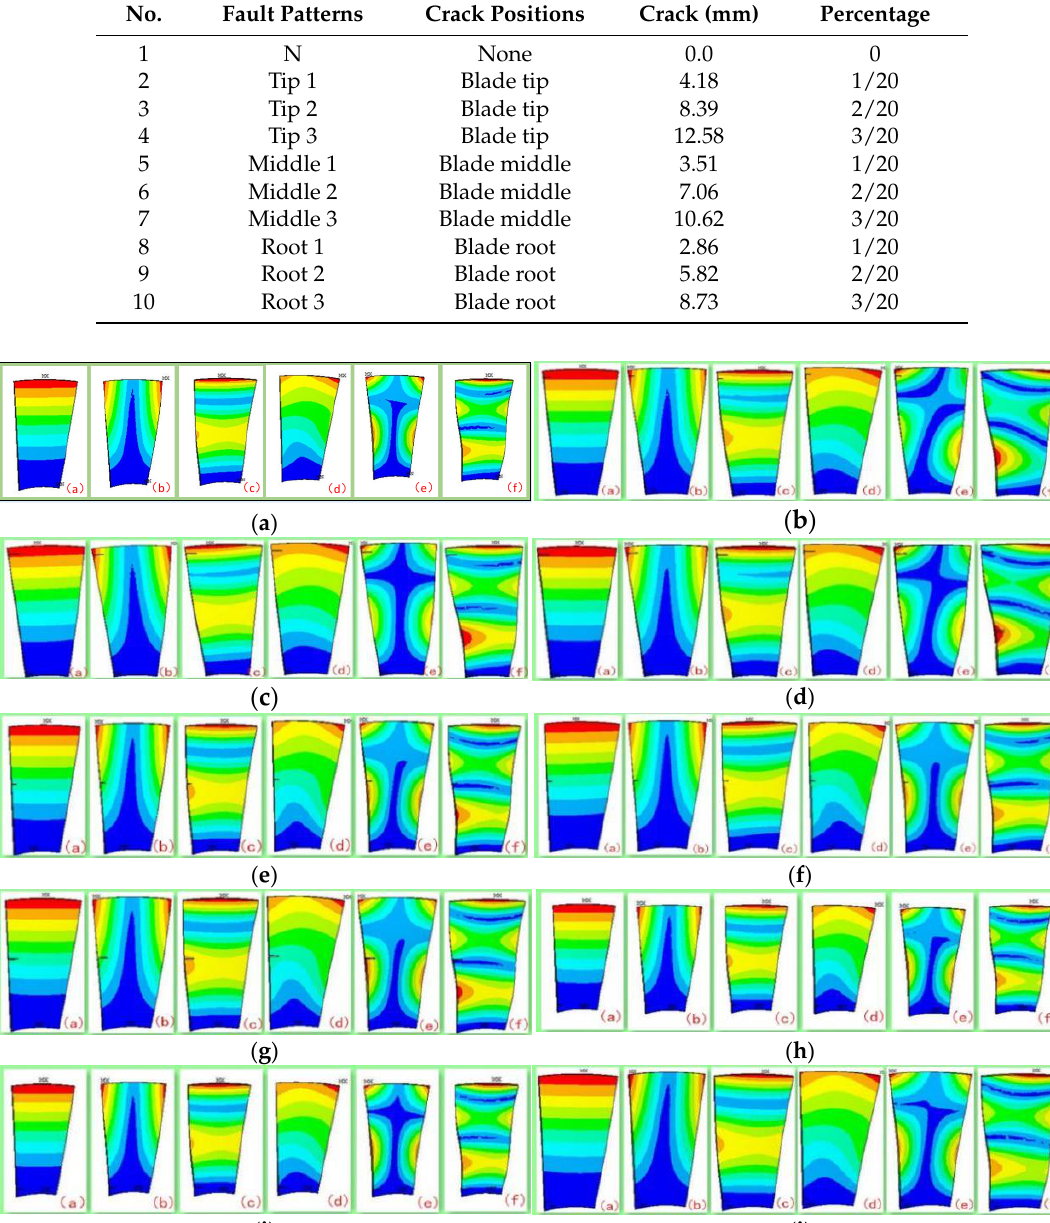
Table 2. Fault pattern of the blades.